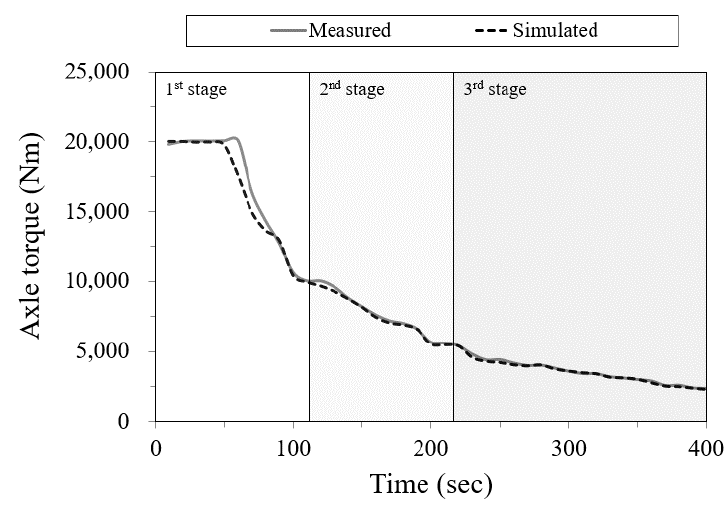
Figure 7. Comparison of axle torque of the HMT for the measured and simulated results according to the gear stages. Table 3. Comparison of the axle torque between the measured and simulated results based on the gear